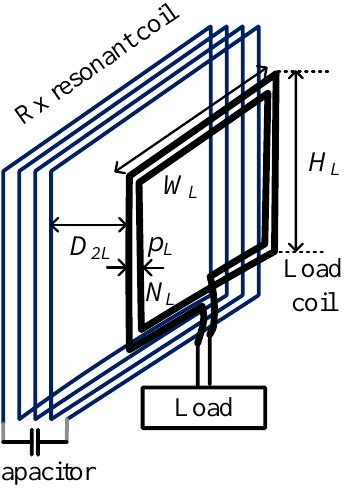
Figure 11. Schematic illustration of an Rx part using a load coil .